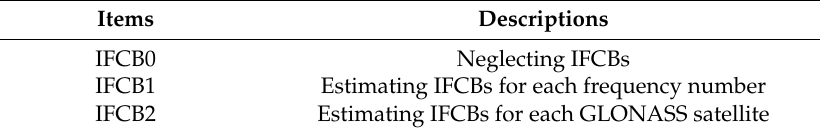
Table 5. GLONASS IFCBs processing schemes. Table 5 . GLONASS IFCBs processing schemes.